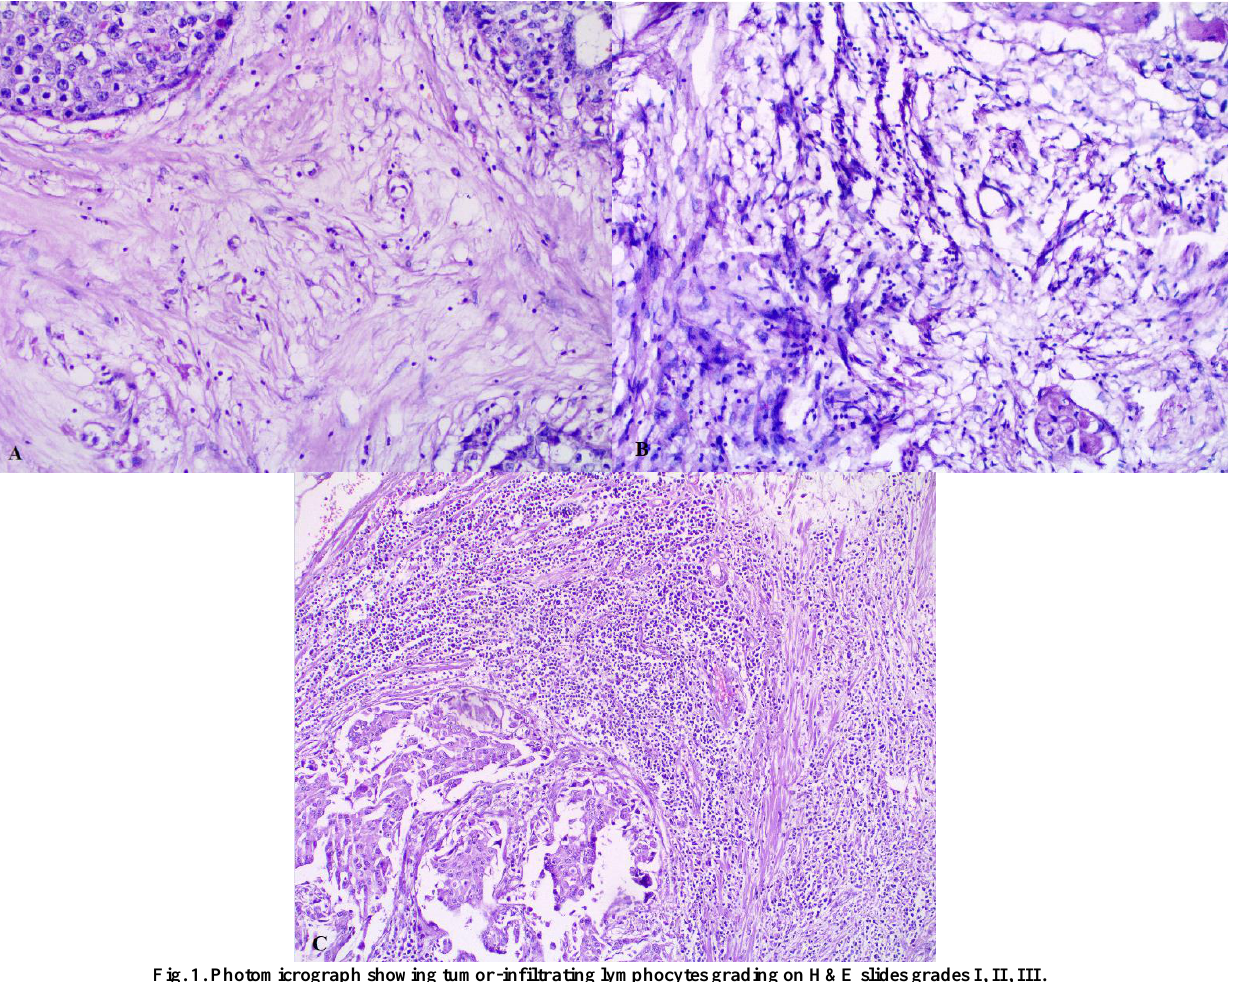
Fig. 1. Photomicrograph showing tumor-infiltrating lymphocytes grading on H&E slides grades I, II,